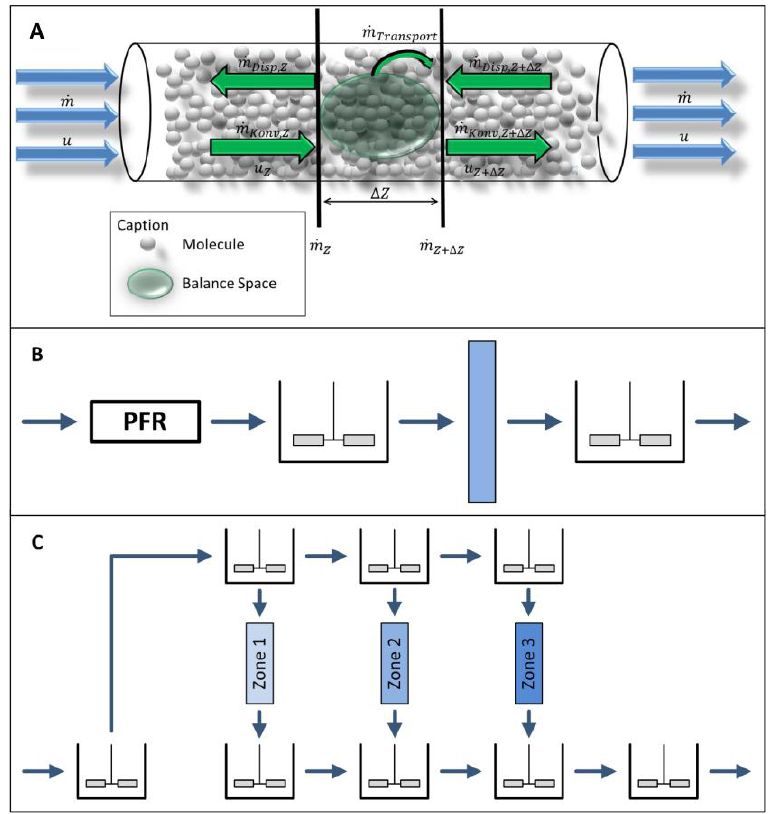
Figure 5. Overview of different fluid dynamic models. ( A ) Distributed plug flow model; ( B ) Roper–Lightfoot model [64]; ( C ) zonal rate model [59,60]. PFR, Plug Flow Reactor.